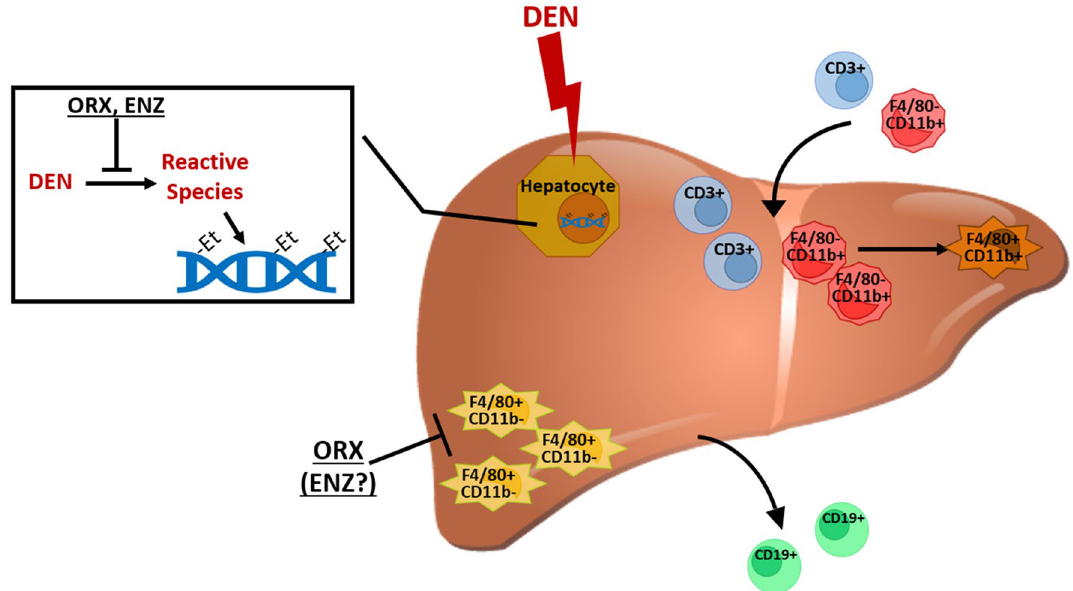
Figure 6. Graphical hypothesis of the impact of AR-signaling on DEN-mediated carcinogenesis. DEN is metabolized by CYP2E1 in hepatocytes into reactive species that create DNA ethyl adducts and induce liver damage. In the acute immune response to DEN, the proportions of CD3+ T cells, F4/80− CD11b+ myeloid lineage cells, and F4/80+ CD11b+ monocyte-derived resident liver macrophages are increased coinciding with a decreased proportion F4/80+ CD11b− Kupffer cells and CD19+ B cells. Inhibition of the AR/androgen signaling axis reduces DNA adduct formation in hepatocytes, decreases liver damage, and decreases baseline F4/80+ CD11b− Kupffer cells, yet does not alter relative immune cell recruitment. The image of the liver is from TogoTV (2016 DBCLS TogoTV / CC-BY-4.0), https ://doi.org/10.7875/togop